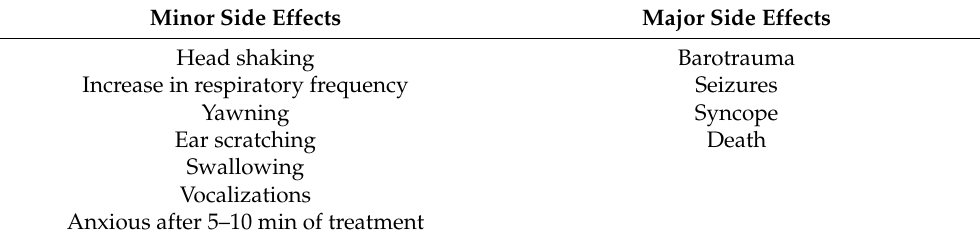
Table 4. Hyperbaric oxygen therapy minor and major side